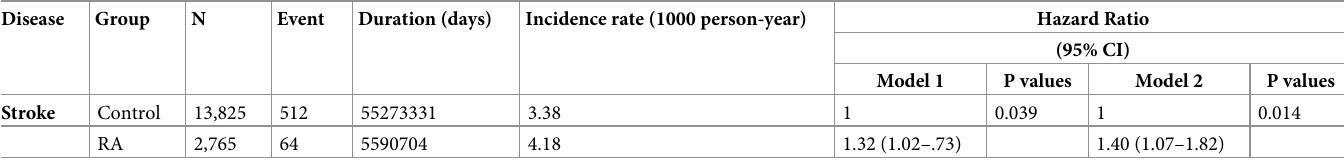
Table 2. Adjusted hazard ratio for ischemic stroke in the seropositive RA and control groups. Disease Group